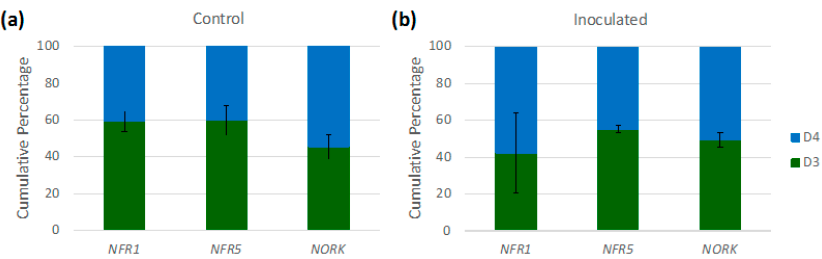
Figure 5. Homoeologue usage with respect to three key nodulation-related signaling receptors, in ( a ) control (mock-inoculated) and ( b ) inoculated samples of allopolyploid T2. Error bars indicate standard deviation.